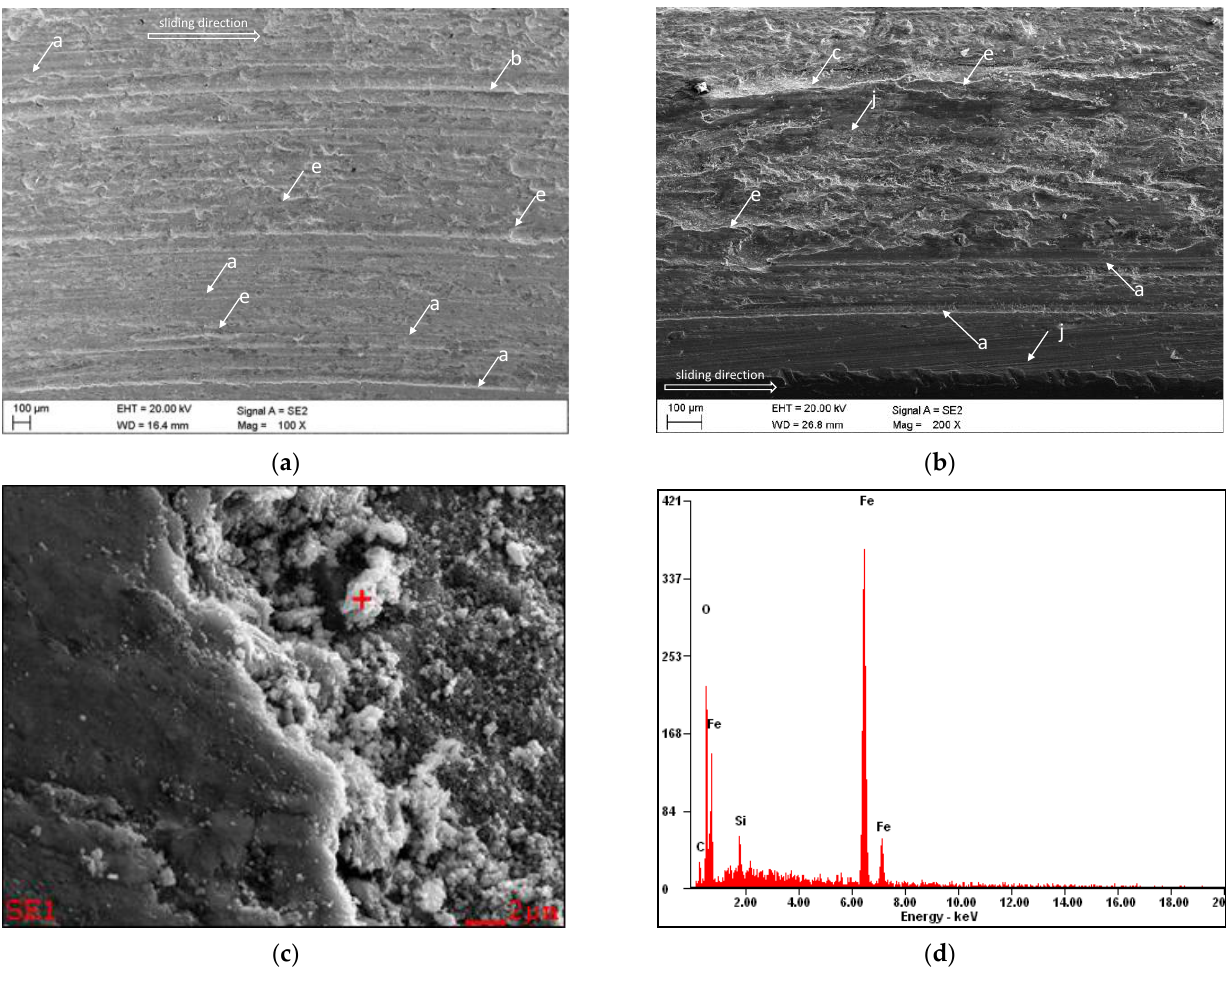
Figure 12. WRS_400_I steel after the tests with the quartz abrasive (Variant II), views of damages in a form of chippings caused by quartz abrasive—SEM ( a , b ); view of the steel fragments in the area of surface chipping ( c ), result of EDS analysis ( d ); symbols: a—grooves, b—plough, c—delamination, e—surface crack (exfoliation), j—smoothing the surface.